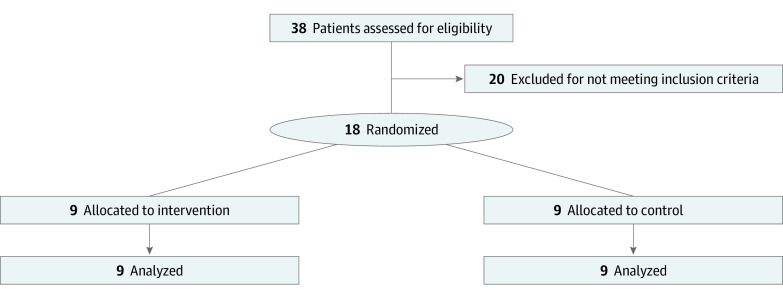
Study Flow Diagram